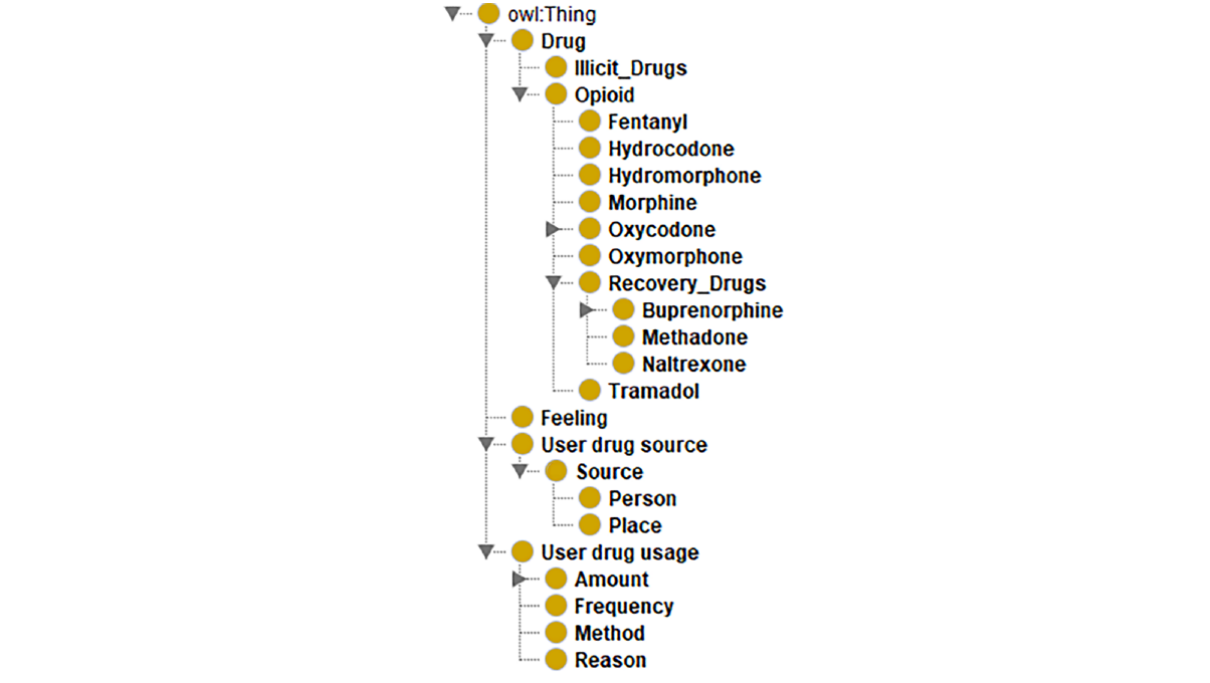
Figure 4. Opioid drug abuse ontology that includes opioid-related terms and concepts.